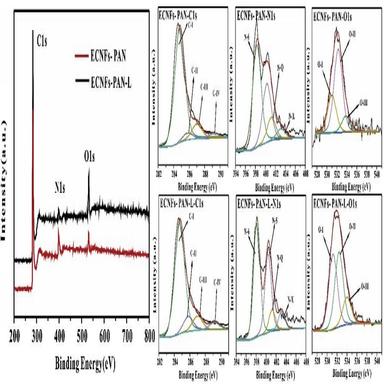
XPS spectra for ECNFs-PAN and ECNFs-PAN-L and the corresponding peaks of C1s, N1s and O1s peaks for both by deconvolution.